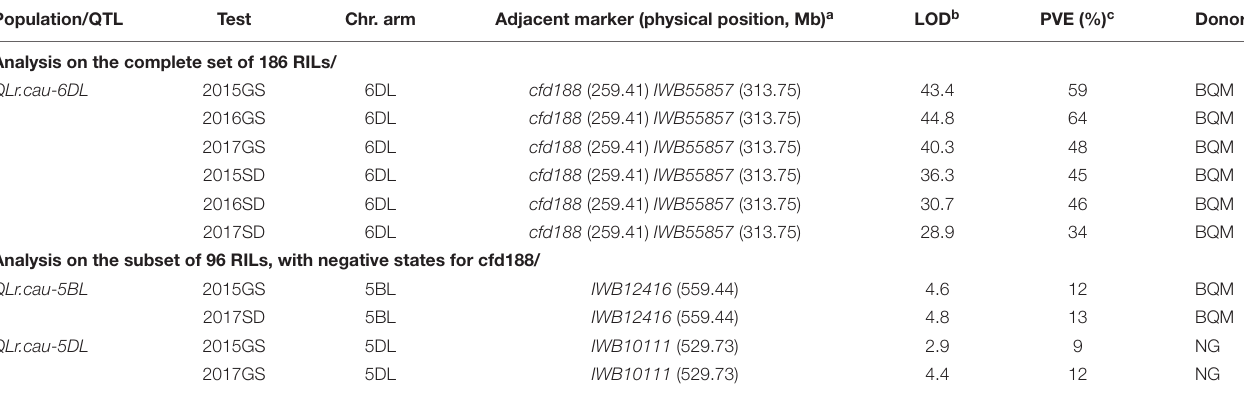
FIGURE 3 | The logarithm of odds (LOD) curves of QLr.cau-6DL detected on chromosome 6D of NG × BQ using leaf rust severities (AUDPC) in field trials under natural infections of Puccinia triticina during 2015–2017 in Gansu (2015GS, 2016GS, and 2017GS) and Shandong (2015SD, 2016SD, and 2017SD). The horizontal line indicates the threshold LOD at 2.9. The gray box indicates the position of the centromere inferred by aligning marker sequences to the chromosome survey sequence. TABLE 5 | Quantitative trait loci (QTL) associated with adult plant resistance to leaf rust detected on the basis of disease severities (AUDPC) in the NG × BQM population tested under natural infections of Puccinia triticina during 2015–2017 in Gansu (2015GS, 2016GS, and 2017GS) and Shandong (2015SD, 2016SD, and